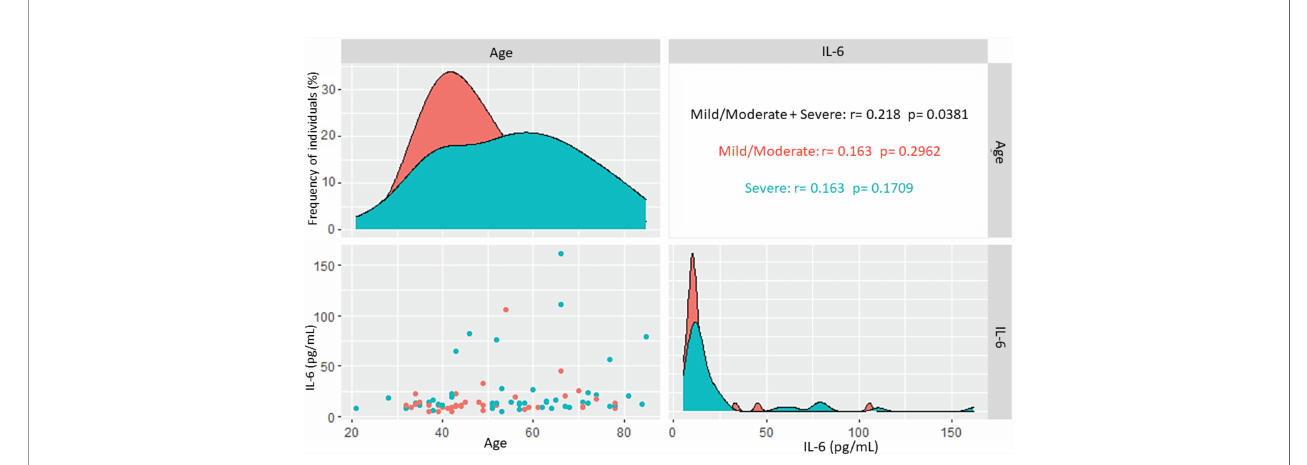
FIGURE 3 | Correlation of IL-6 levels and age in acute COVID-19. Correlation of all patients and patients with mild/moderate and severe forms of the